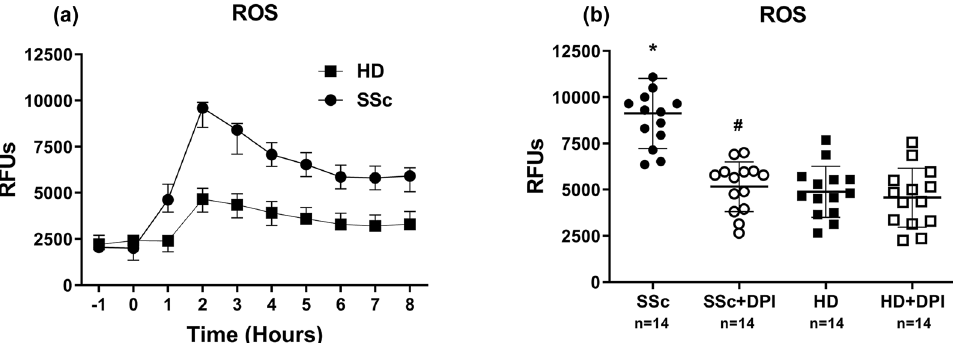
Figure 1: E ff ect of SSc sera on HPMEC intracellular ROS levels: ( a ) SSc sera increase intracellular ROS production in HPMEC. The real - time assessment of intracellular ROS production in HPMECs exposed to sera of SSc patients and healthy donor. Before sera stimulation, subcon fl uent HPMECs were loaded with 10µM of H 2 - DCFDA and then cultured in basal medium containing 10% ( v/v ) of sera from SSc patients ( SSc ) and healthy donor ( HD ) . Variations in intracellular ROSlevels werekineticallydetermined in an 8htime - course ( a randomlyselectedrepresentative experiment is reported ) and values at 2h were used for comparisons in B. ( b ) SSc sera - induced ROS increase in HPMECs is mediated by NADPH oxidases. Before sera stimulation, subcon fl uent HPMECs were loaded with 10µM of H 2 - DCFDA and then cultured for 8h in basal medium containing 10% ( v/v ) of sera from SSc patients and HD, then values at 2h were used for comparisons. In selected experiments, H - DCFDA - loaded subcon fl uent 2 content and expressed as mean ± SD of the RFUs. ( b ) Horizontal lines indicate the mean value and standard deviation range. Kruskall – Wallis one - way analysis of variance, followed by a post hoc Dunn ’ s test for multiple comparisons, was used to detect di ff erences among studied groups. * p ≤ 0.001, signi fi cantly di ff erent from the control group ( HD ) ; # p ≤ 0.0001, signi fi cantly di ff erent from the SSc